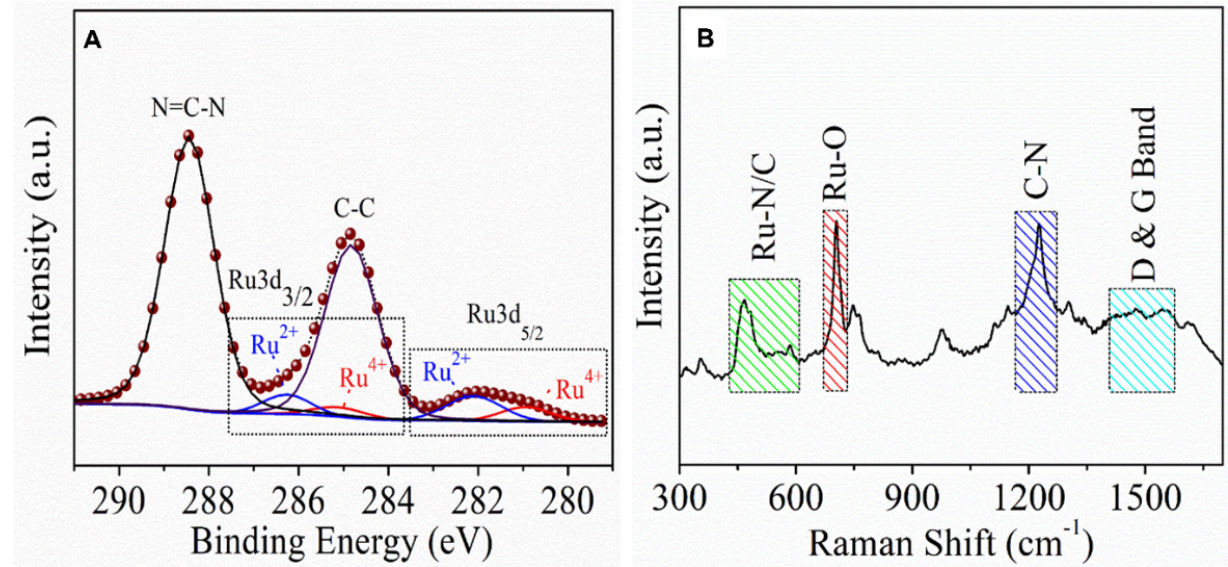
Figure 1. ( A ) Ru 3d high-resolution XPS spectra of SRu-mC 3 N 4 ; ( B ) Raman spectra of SRu-mC 3 N 4 .